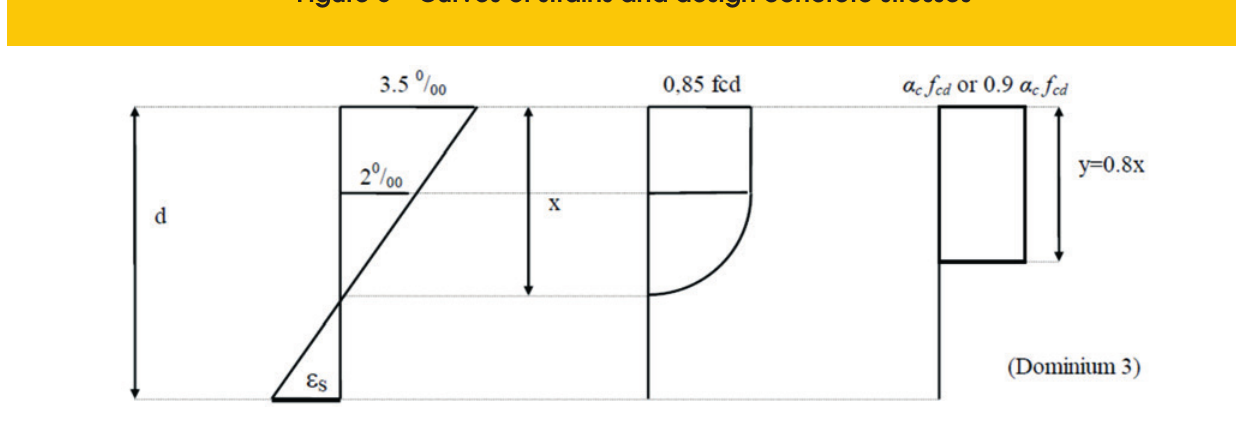
Figure 6 – Curves of strains and design concrete